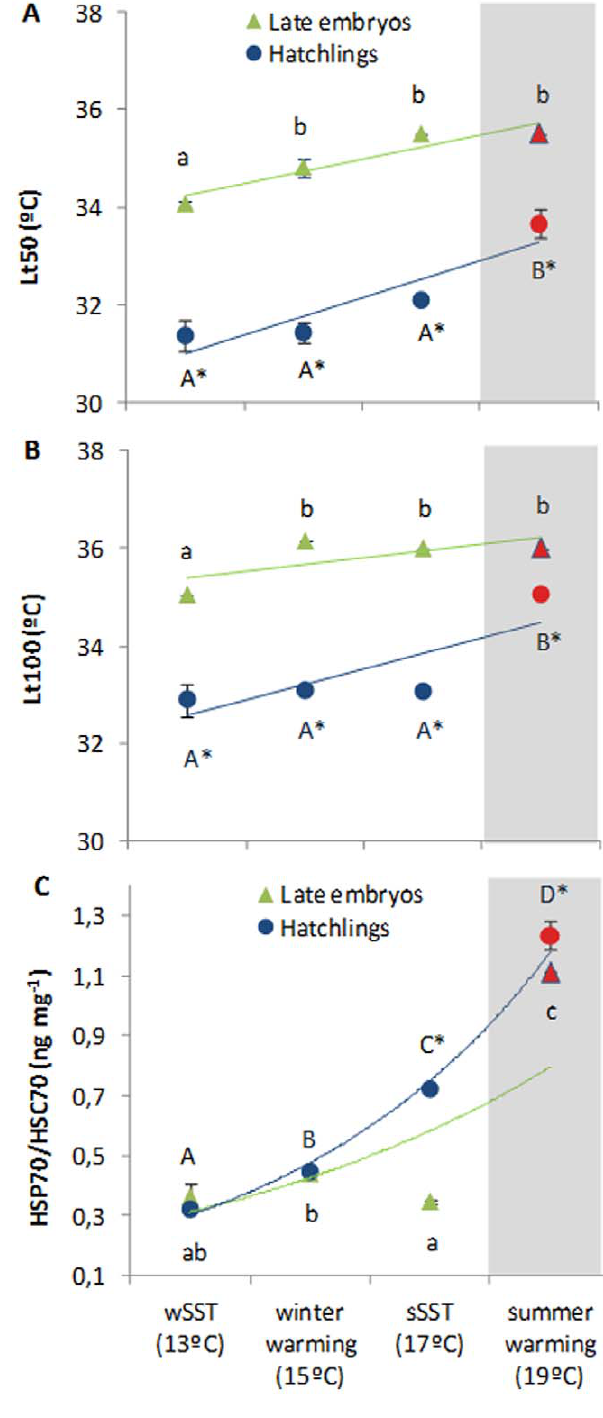
Figure 6. Thermal tolerance limits (A - Lt50, 6 C; B - Lt100, 6 C) and heat shock response (HSP70/HSC70, ng mg 2 1 ) (C) of late embryonic stages and hatchlings of the squid Loligovulgaris at the different temperature scenarios (red symbols highlight the future summer scenario). Values are mean 6 SD. Colored lines represent trendlines and different letters (capital letters for hatchlings; small letters for embryos) and asterisk represent significant differences between temperatures and developmental stages, respectively (more statistical details in Supporting Tables).